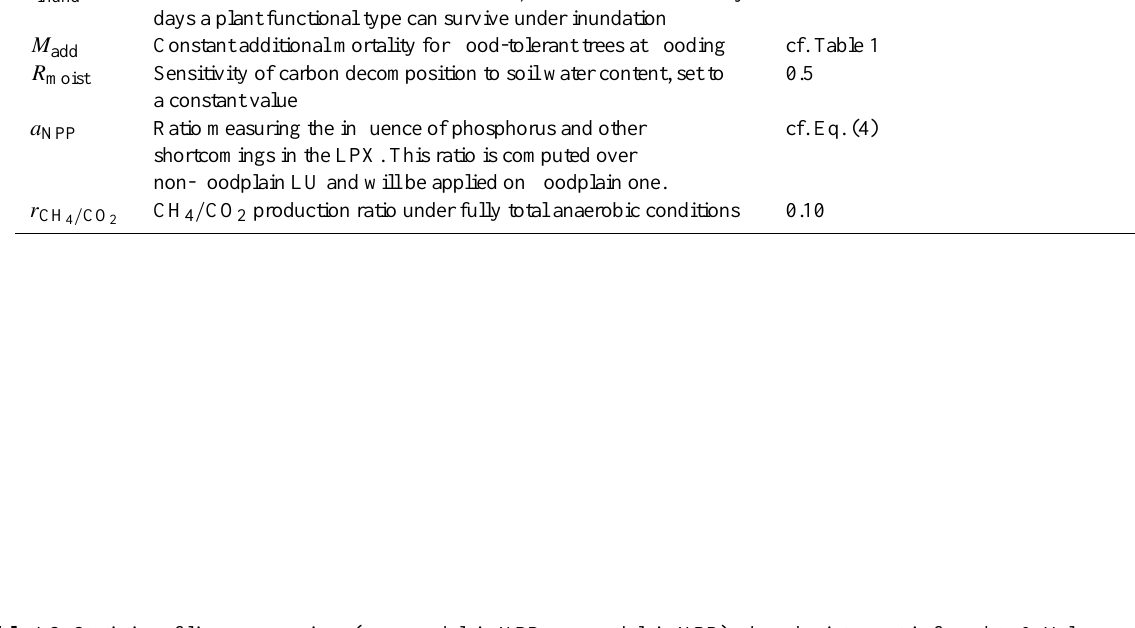
Table A2. Statistics of linear regressions (non-floodplain NPP vs. floodplain NPP) when the intercept is forced to 0. Values are given for LPX (three simulations varying through the parameters combinations, see Table 1) and for MODIS (for both trees and